Question: Write a single sentence explaining what this figure depicts.
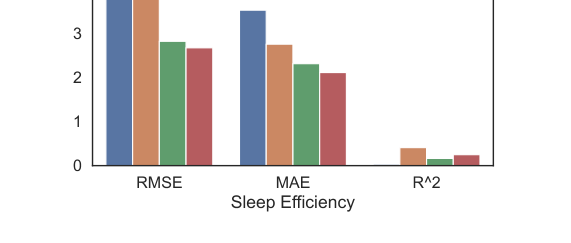
Answer: The performance of the proposed model with other baseline models, proposed by Xu et al. (2019), Farhan et al. (2016), and Wahle et al. (2016).